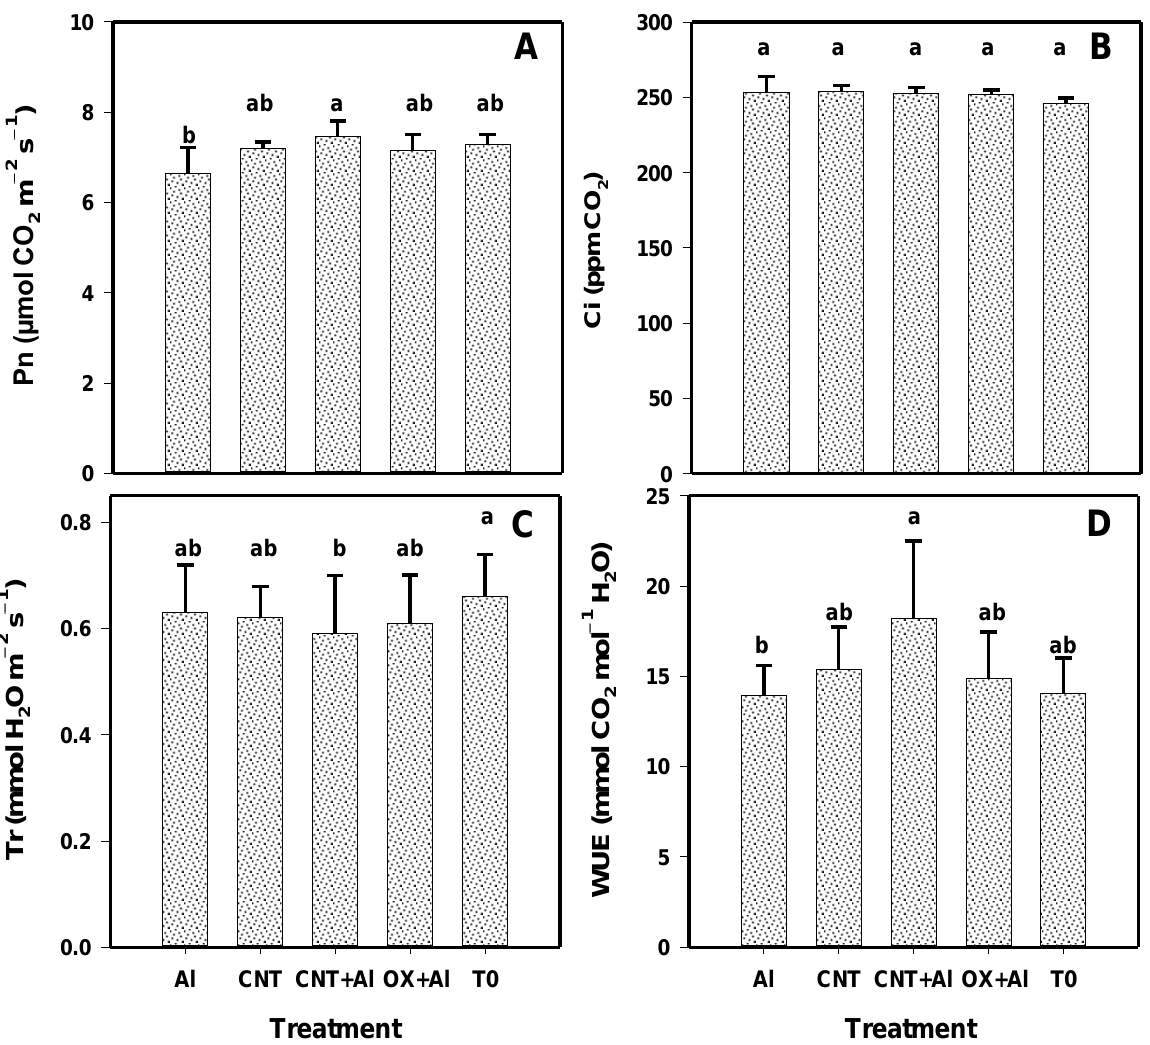
Figure 7. Net photosynthesis rate (Pn) ( A ), internal CO 2 concentration (Ci) ( B ), transpiration (Tr) ( C ), and water use efficiency (WUE) ( D ) in leaves of tomato plants. Al: Positive control inoculated with A. solani ; CNT: Carbon nanotubes; OX: Commercial control; T0: Control. Different letters indicate significant differences between treatments according to the least significant difference of Fisher test (α = 0.05). N = 5 ± standard error.